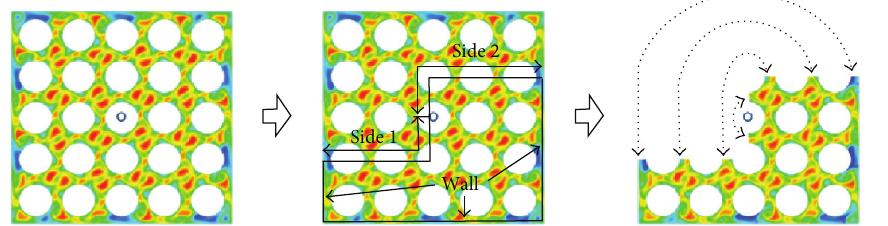
Figure 7: Rotational periodicity boundary condition.